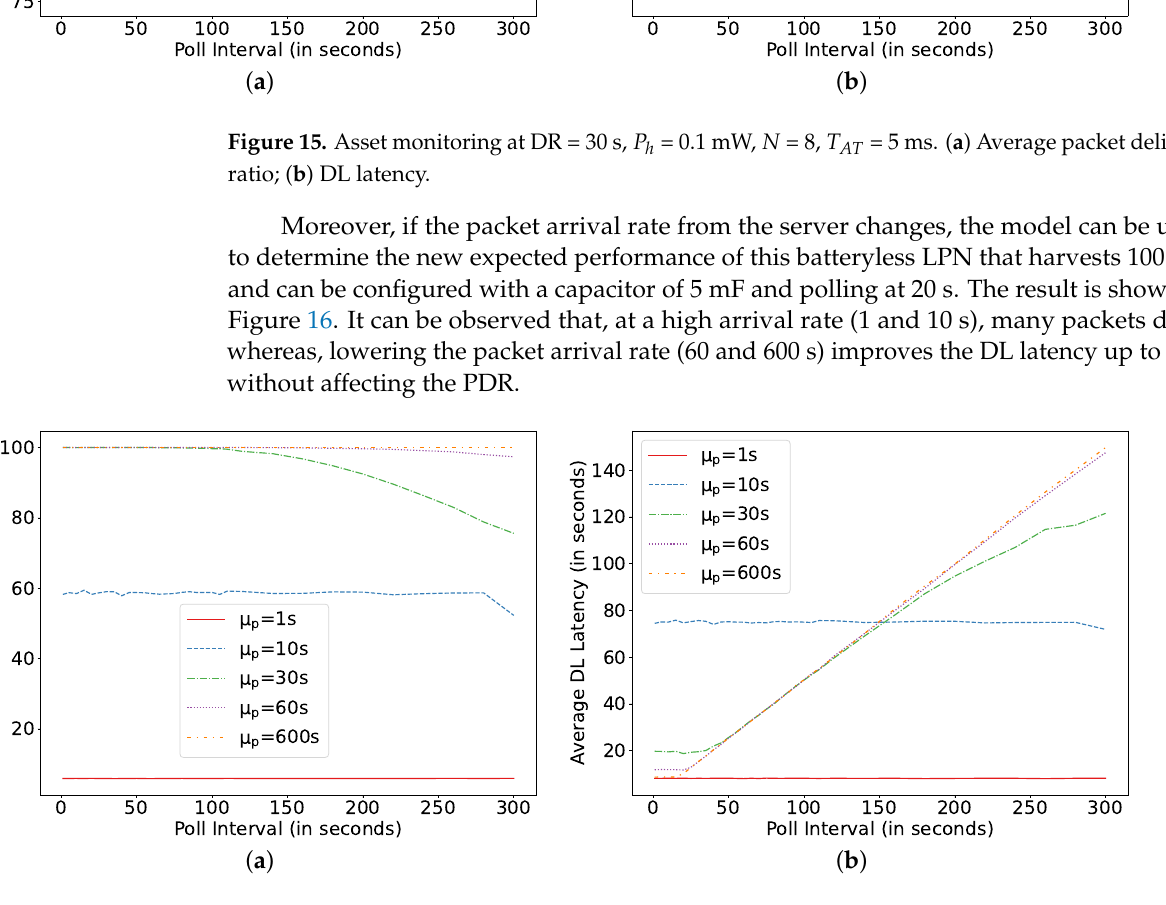
Figure 16. Asset monitoring at C = 5 mF, P h = 0.1 mW, N = 8, T AT = 5 ms for different packet arrival rate. ( a ) Average packet delivery ratio; ( b ) DL